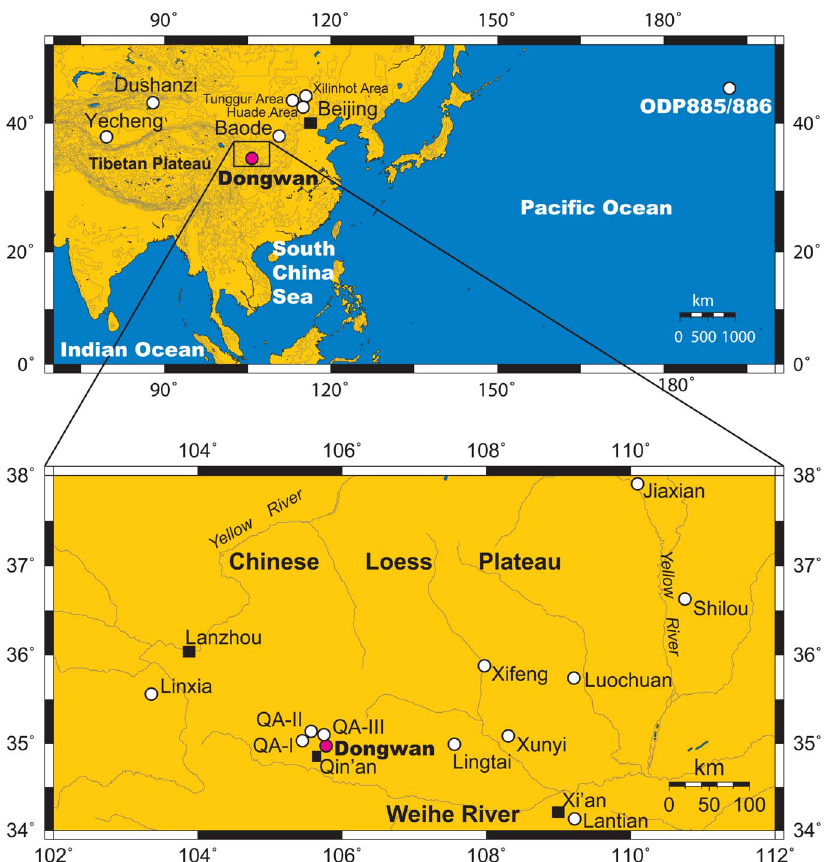
Figure 1. Location of the Chinese Loess Plateau (CLP), the studied Dongwan loess-paleosol sequence and other Neogene sections mentioned in the text. The Dongwan sequence is indicated by a red circle and other sections by white circles. Main cities are indicated by black squares.